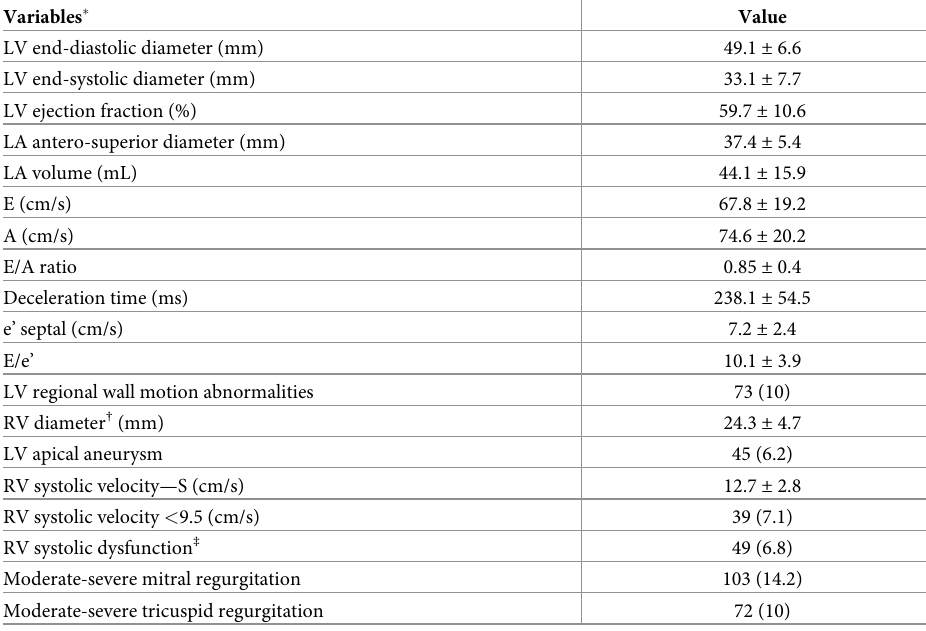
� Data are expressed as the mean value ± SD, median (interquartile range), or absolute numbers (percentage). † Linear dimension measured from the anterior RV wall to the interventricular septal-aortic junction (in parasternal long-axis view). ‡ RV systolic dysfunction by qualitative assessment using different two-dimensional views, range from mild to severe dysfunction.